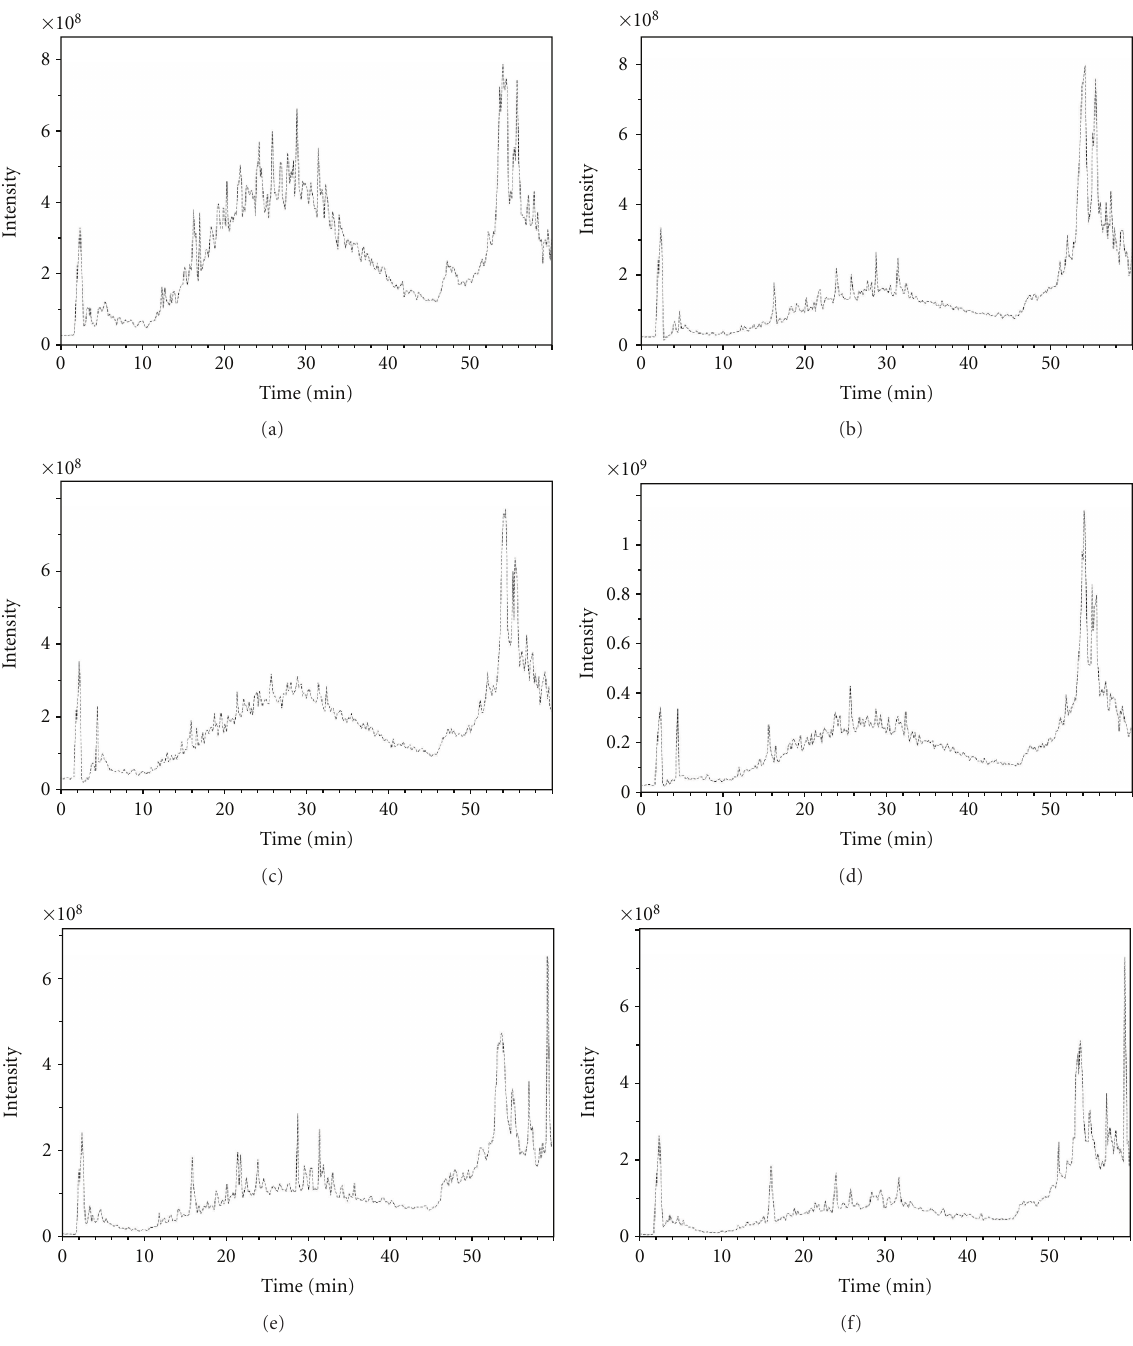
Figure 3: HPLC/MS analysis of horn samples digested by trypsin (a) 1.7 PGV, (b) 1.7DGV, (c) 3DGV, (d) 3 DGN, (e) 2.5DGN, and (f) DGV II 2